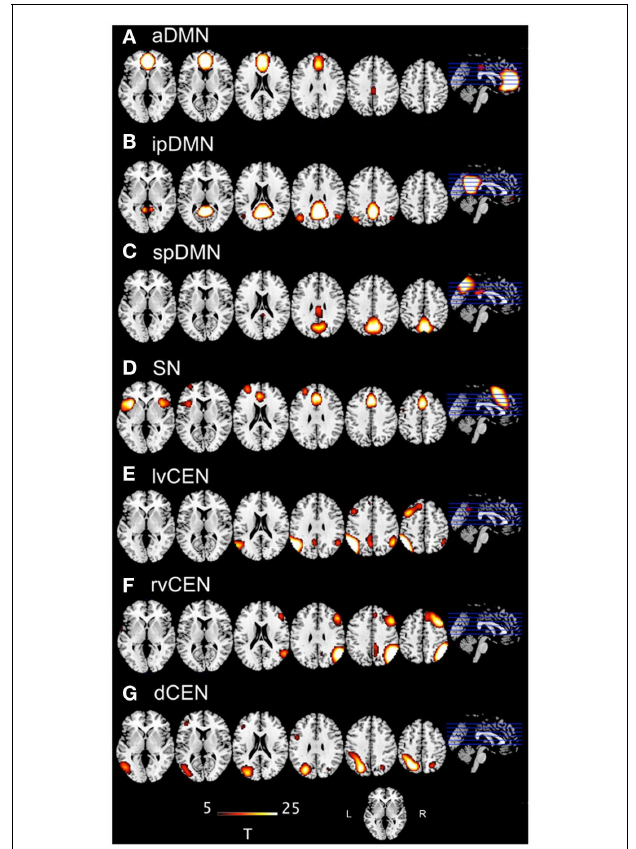
FIGURE 1 |T-maps of intrinsic connectivity networks of interest as described and provided online byAllen et al. (2011) . Allen and colleagues used an ICA model-order of 75 to decompose rs-fMRI data of 603 subjects, obtaining 28 components.T-maps of components were provided online (http://mialab.mrn.org/data/hcp/RSN_HC_unthresholded_tmaps.nii). In the present study, we chose theT-maps of ICs representing the default mode network, salience network and central executive network, and performed multiple spatial regression analyses of our 75 independent components’ spatial maps on these templates to select the networks-of-interest in an automated and objective way. Here, providedT-maps were superimposed on a single-subject high resolutionT1 image (color scale representing t -values from 5 to 25). (A) Anterior default mode network (aDMN), corresponding to Allen-IC 25. (B) Inferior-posterior default mode network (ipDMN), corresponding to Allen-IC 53. (C) Superior-posterior default-mode network, corresponding to Allen-IC 50. (D) Salience network (SN), corresponding to Allen-IC 55. (E) Left-ventral central executive network (lvCEN), corresponding to Allen-IC 34. (F) Right-ventral central executive network (rvCEN), corresponding to Allen-IC 60. (G) Dorsal central executive network (dCEN), corresponding to Allen-IC